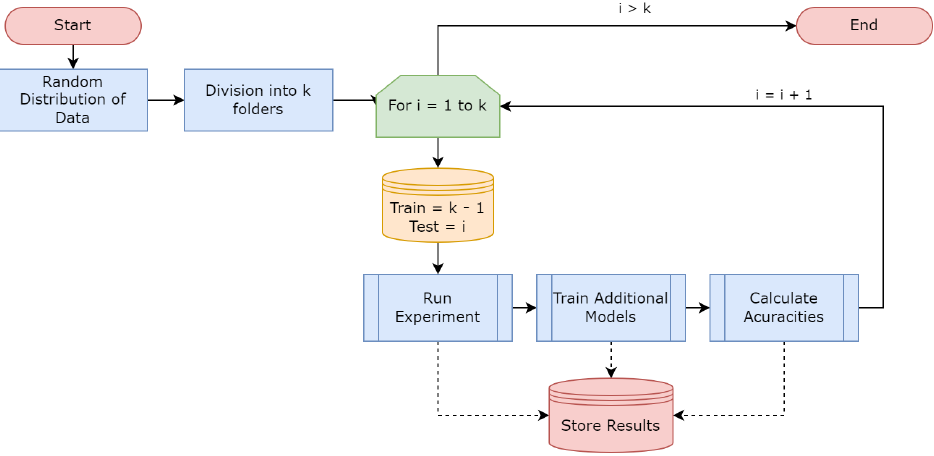
Figure 10. Process for experiment execution, based on cross-validation by [78].